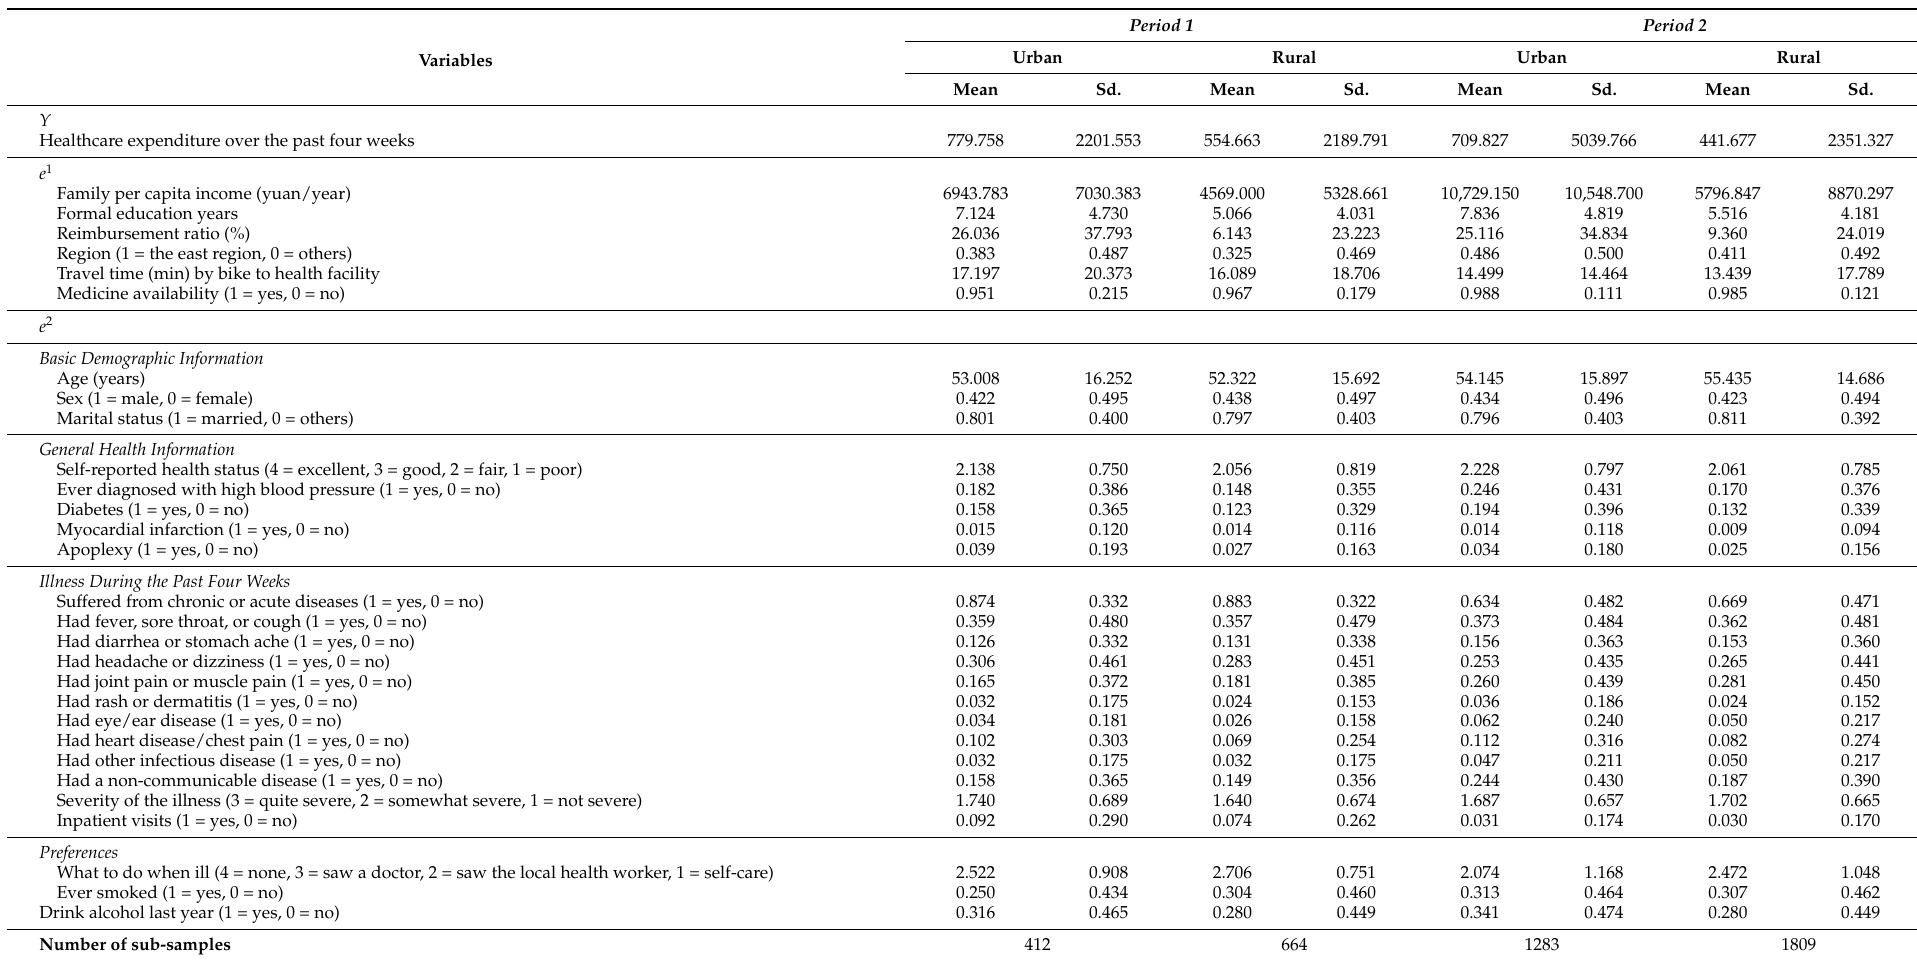
Table 1. Description of